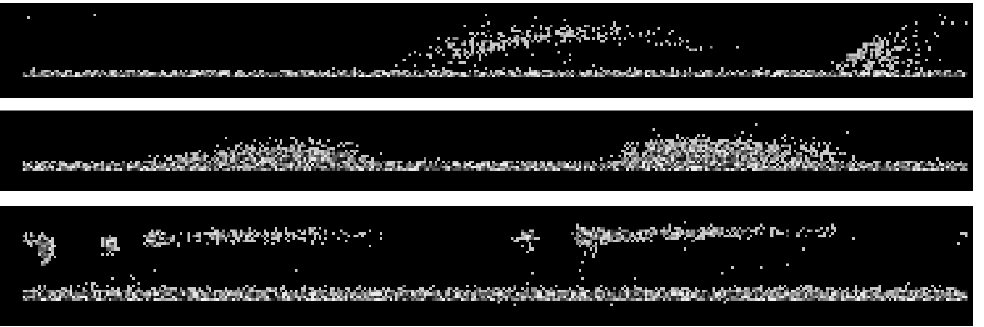
Figure 1. Examples of positive PRPD samples. Top : Internal discharge, Middle : Internal discharge from 22 kV bushing of oil-filed transformer, Bottom : Internal discharge from voids of solid